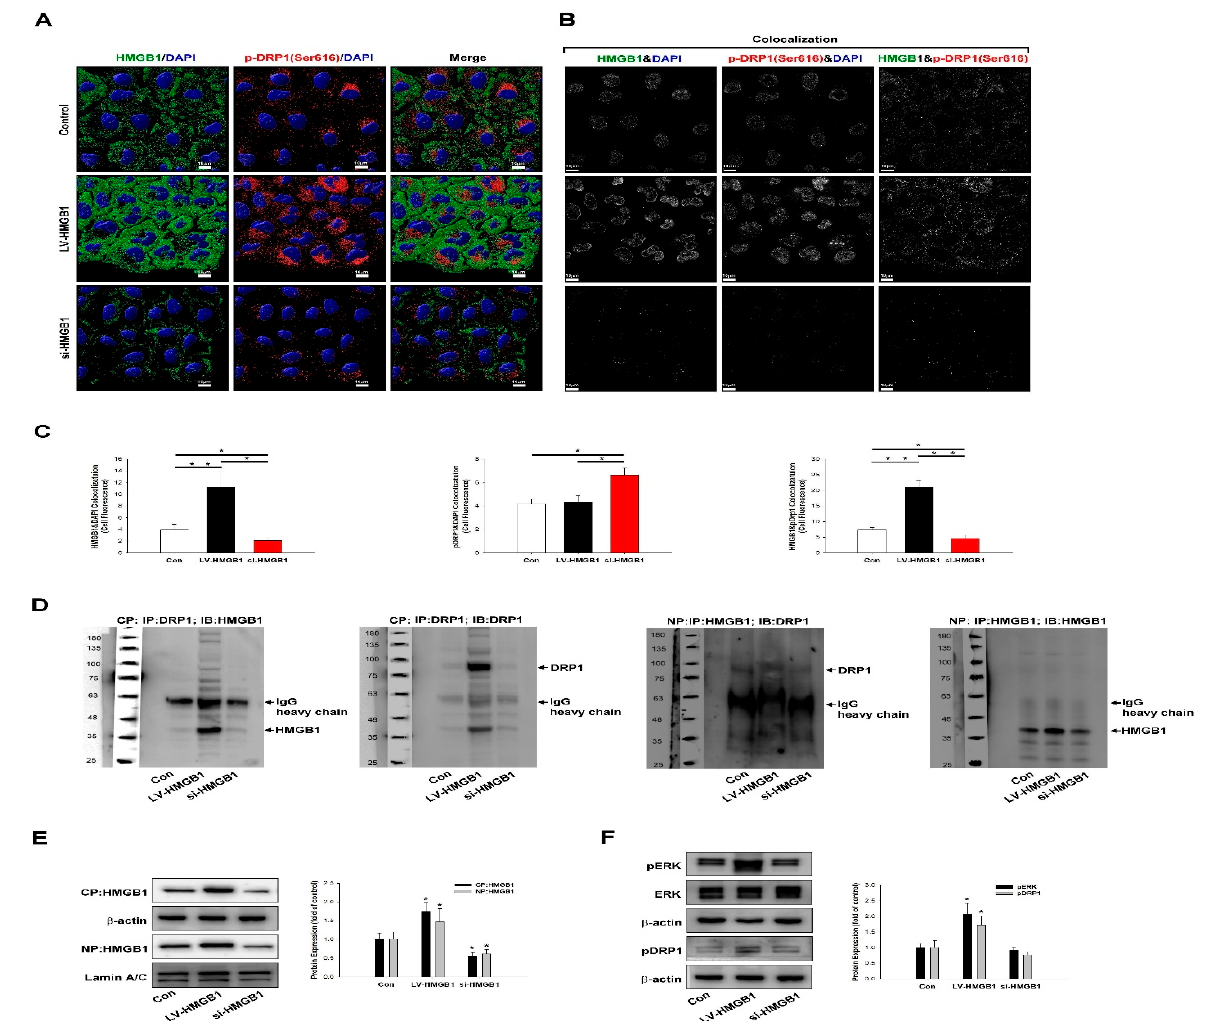
Figure 4. HMGB1 regulates DRP1 phosphorylation and colocalization. A549 cells were transfected with LV-HMGB1 or si-HMGB1 for 48 h. ( A ) Cells were stained with HMGB1 (green color), pDRP1 (Ser616) (red color), and nucleus dye (blue color), and they were analyzed using confocal microscopy and the Imaris software. ( B , C ) To validate that HMGB1 regulates pDRP1 (Ser616) expression, confocal analysis, image construction, and quantification were done using the Imaris software. Data are representative of three independent experiments. ( D ) HMGB1 colocalization with pDRP1 (Ser616) was determined by co-immunoprecipitation. ( E , F ) The regulation pathway was examined by a Western blot assay. * p < 0.05 compared with the control. Con: control. CP: cytosolic protein; NP: nucleus protein; IP: immunoprecipitation; IB: immunoblotting; IgG: immunoglobulin G; Lamin A/C: nucleus protein internal